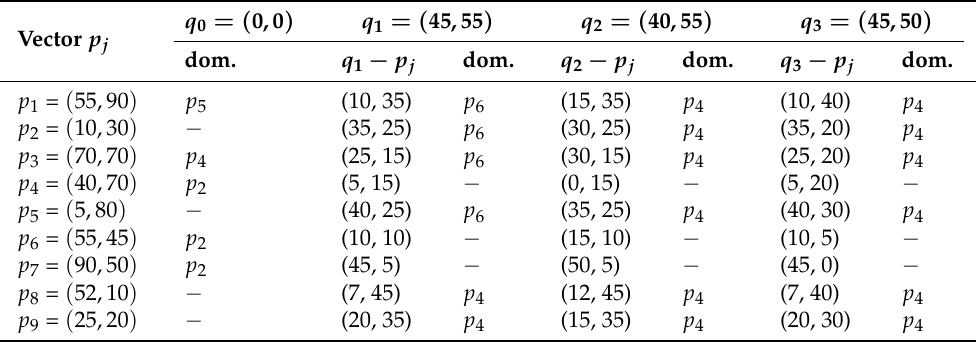
Table 1. Feature vectors of our running example with skyline set (with respect to q 0 ) and dynamic skyline set for three different query points q 1 , q 2 , and q 3 . The columns q i − p j show the absolute difference between a query vector q i and a feature vector p j in each dimension. We show in the column dom by which vector the vector in the respective row got dominated; here a dash ( − ) says that this vector is not dominated by any vectors of the input set. Dominated vectors are not part of the skyline